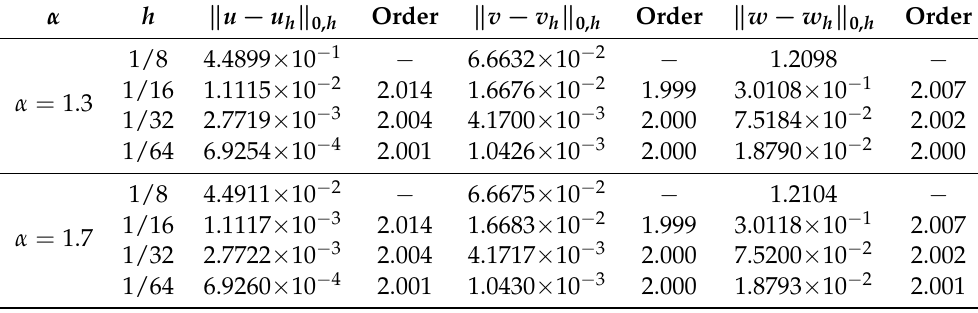
Table 3. L 2 -norm errors and spatial convergence order of MFVE method.